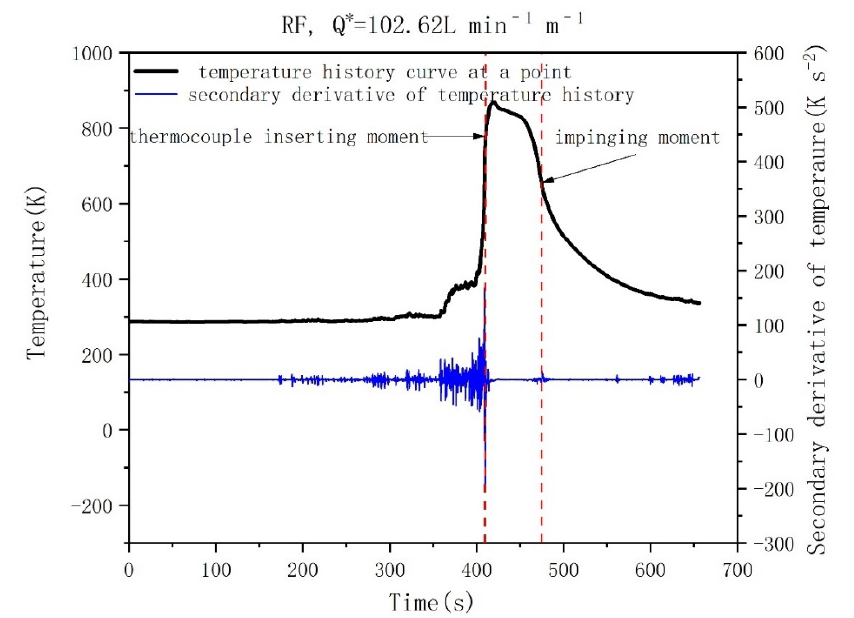
Figure 7. Graphic illustration determining the moment of thermocouples insertion into the melt and water impinging on the ingot surface.